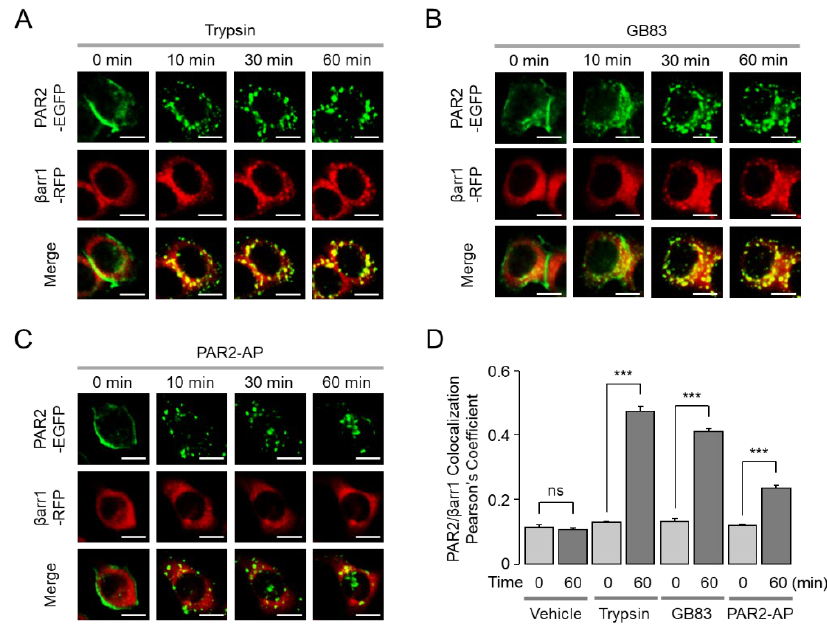
Figure 6. GB83 induces sustained colocalization of PAR2 and β -arrestin1. ( A – C ) Effect of trypsin, GB83, and PAR2-AP on the localization of PAR2 and β -arrestin1 ( β arr1) in HT-29 cells expressing EGFP-tagged PAR2 and RFP-tagged β -arrestin1. Cells were treated with trypsin (30 U/mL), GB83 (30 µM), PAR2-AP (30 µM), and the cellular localization of PAR2 (green) and β -arrestin1 (red) were observed at 0, 10, 30, and 60 min after treatment of each agonist. ( D ) Quantitative analysis of colocalization of PAR2 and β -arrestin1 (mean ± S.E., n = 5). Colocalization values were calculated in Pearson’s correlation coefficient using the colocalization plugin JACoP. Statistical significance of differences between indicated groups was assessed by one-way ANOVA with Tukey’s post-hoc test. *** p < 0.001, ns, not significant.